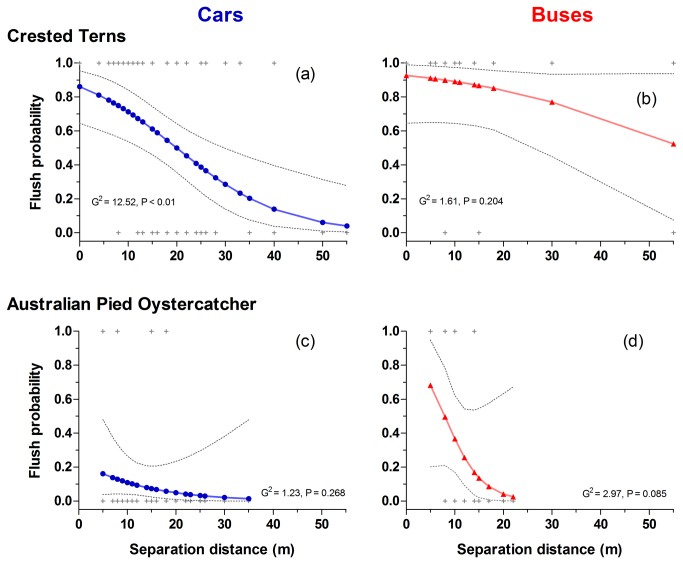
Logistic regressions modelling the probability of flushing (i.e. the probability of birds escaping vehicles by taking flight) of terns (a and b) and oystercatchers (c and d) in relation to distance between birds and cars (left column), and birds and buses (right column).Solid lines connect predicted probabilities at observed distances; dotted lines are 95% confidence limits of model predictions, and crosses are observed flight responses.